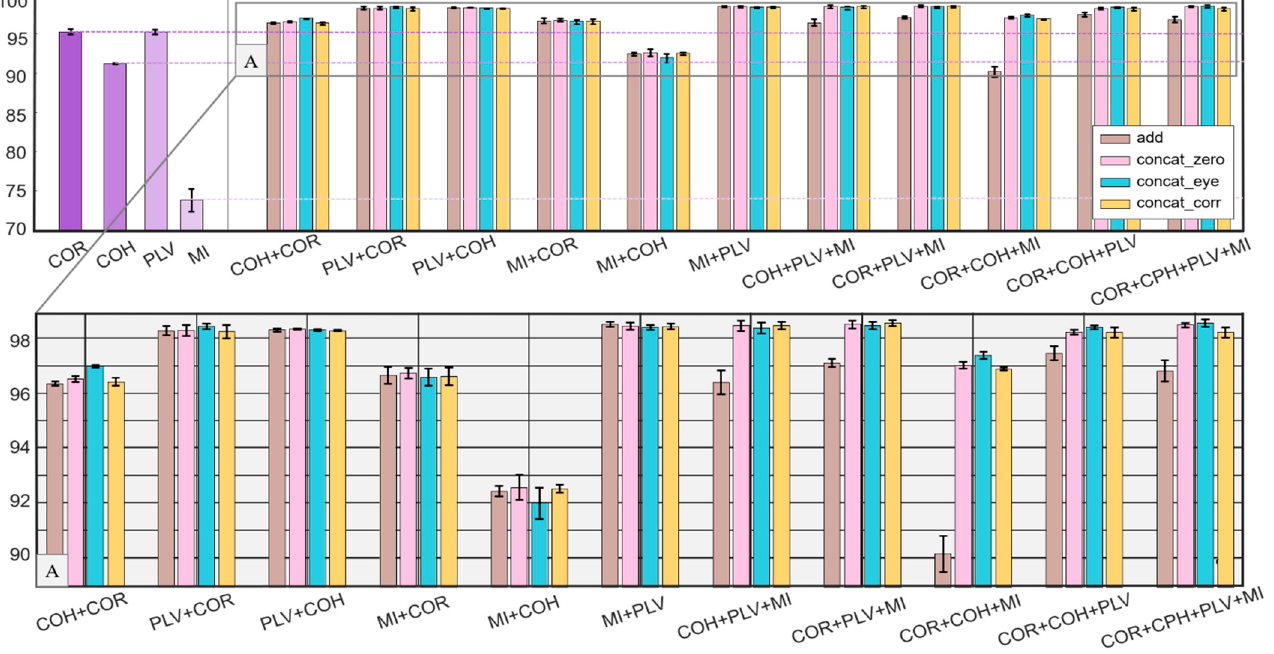
Figure 3. Comparison between using single FC and multiple FCs on classification accuracy. Upper left: accuracy by using single FC. Upper right: accuracy by using 11 different FC combinations with four different fusion methods. Below: the enlarged view of the rectangle in the upper right figure. It can be seen that all four fusion methods are more effective than a single FC in the case of two-FC combination. The best two-FC combination is MI+PLV , which achieves an accuracy of 98.51% with the add-fusion. However, in the case of three-FC combination and four-FC combination, accuracy is not always higher than that in two-FC combination. The accuracy of the combination COR+COH+MI with the add-fusion is 90.16%, which is lower than the combination COH+COR (96.36%), MI+COR (96.66%), and MI+COH (92.43%).